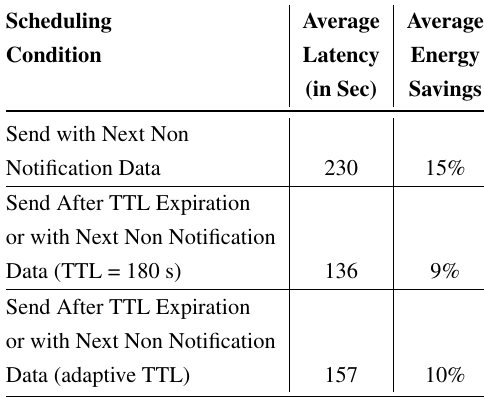
Figure 9: TTL value vs Energy